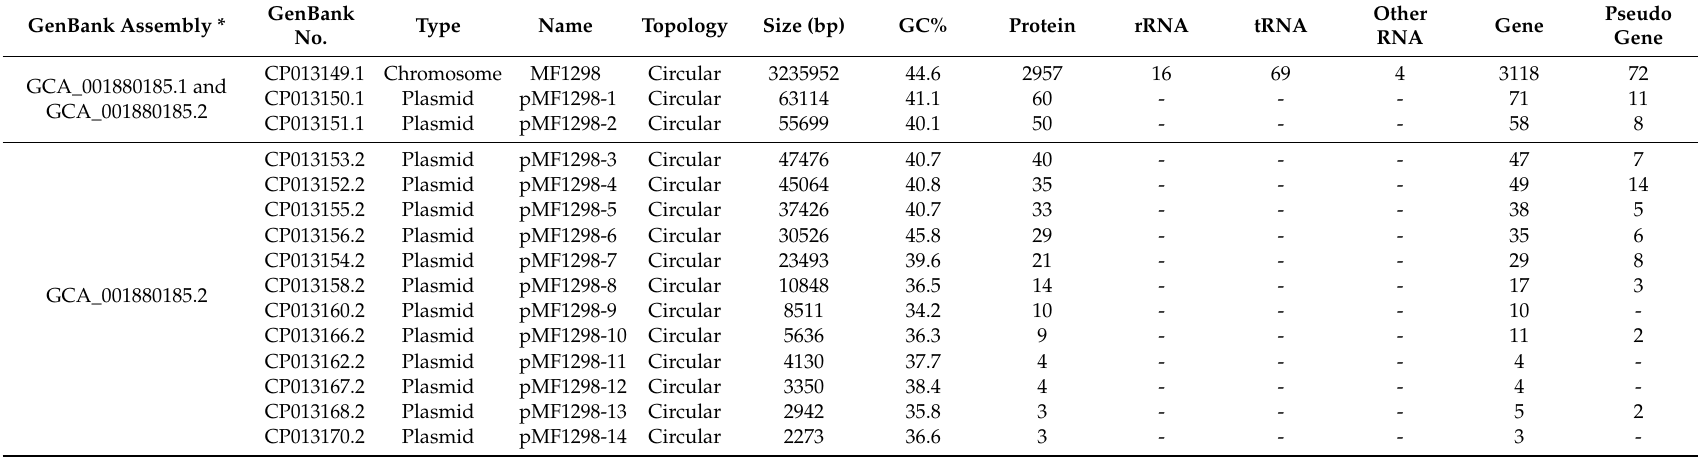
Table 1. Genome features of Lactobacillus plantarum